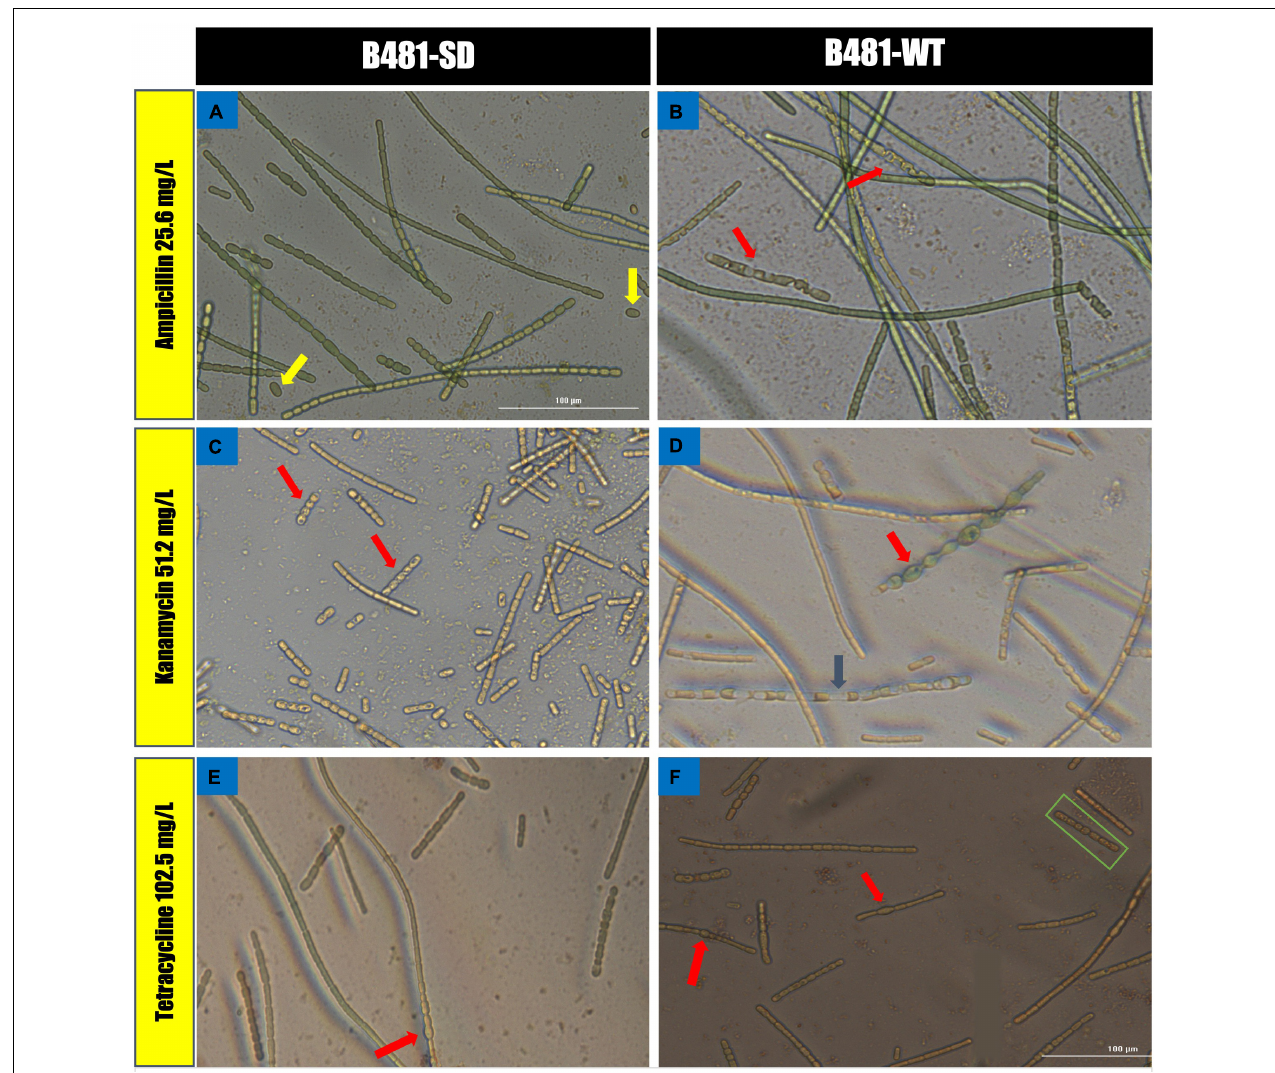
FIGURE 6 | Morphological alterations of Fremyella diplosiphon strains in concentrations at 25.6 mg/L ampicillin (A,B) , 51.2 mg/L kanamycin (C,D) and 102.5 mg/L tetracycline (E,F) treatments. Representative sections of color bright field images were captured using a cytation 5 Cell Imaging Multi-Mode reader at 40 × magnification bars, 100 µ